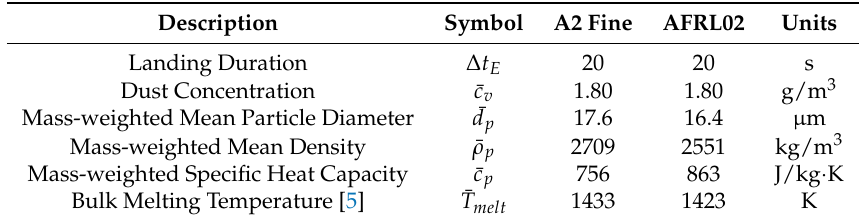
Table 1. Physical and chemical properties of two mineral dust brownout clouds.